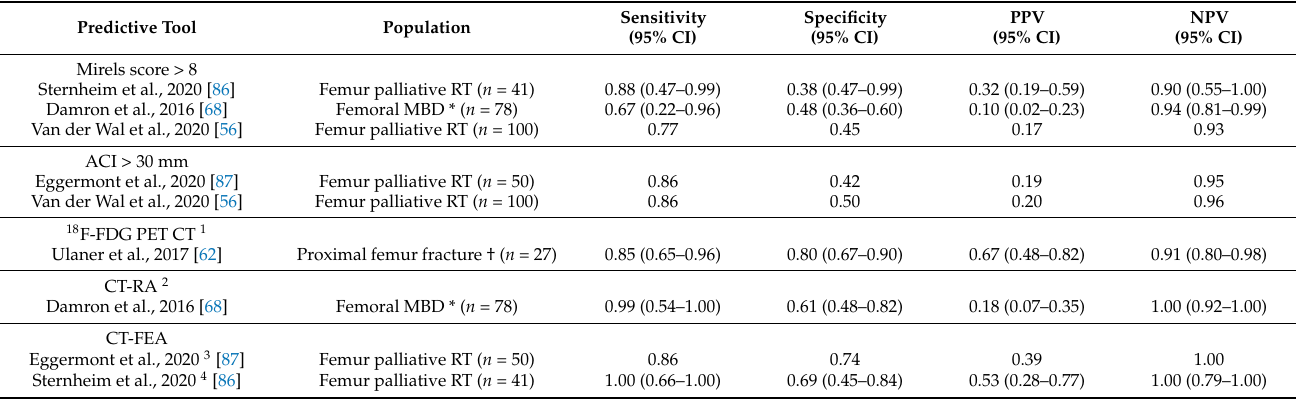
Table 3. Diagnostic values comparison. 1 Total lesion glycolysis > 81; 2 reduction > 35% in axial, bending, or torsional rigidities; 3 linear model, failure load < 7.5 × BW; 4 non-linear model, SFR > 1.48; RT: radiation therapy; MDB: metastatic bone disease; * carcinoma, myeloma, and lymphoma patients; † in breast cancer